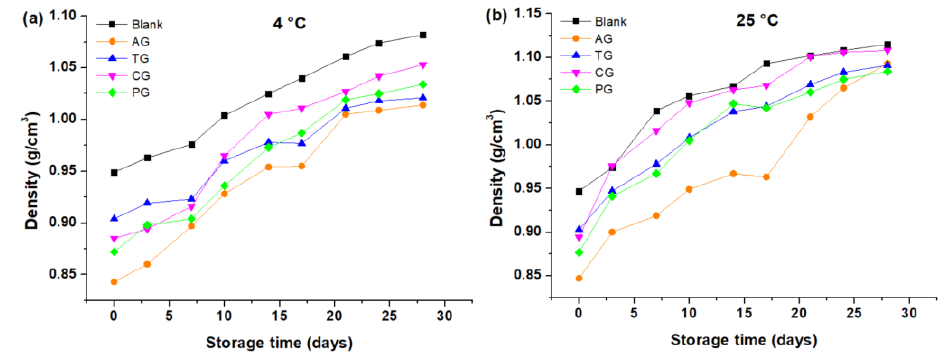
Figure 2. Density as a function of storage time: ( a ) Creams stored at 4 °C; ( b ) Creams stored at 25